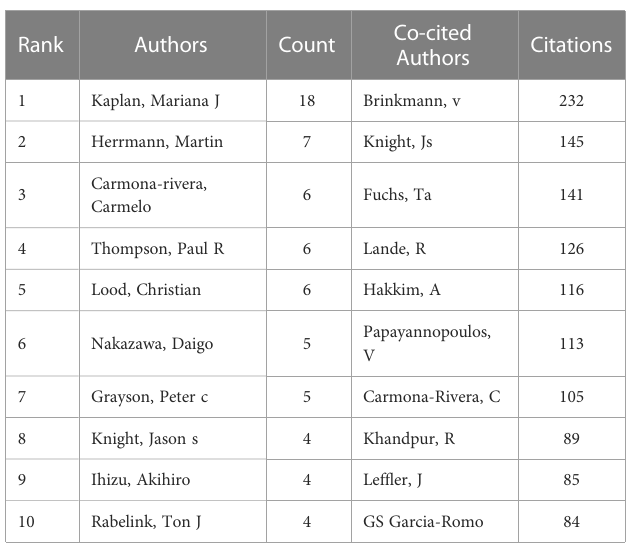
TABLE 3 Top 10 authors and co-cited authors on the research of NETs in